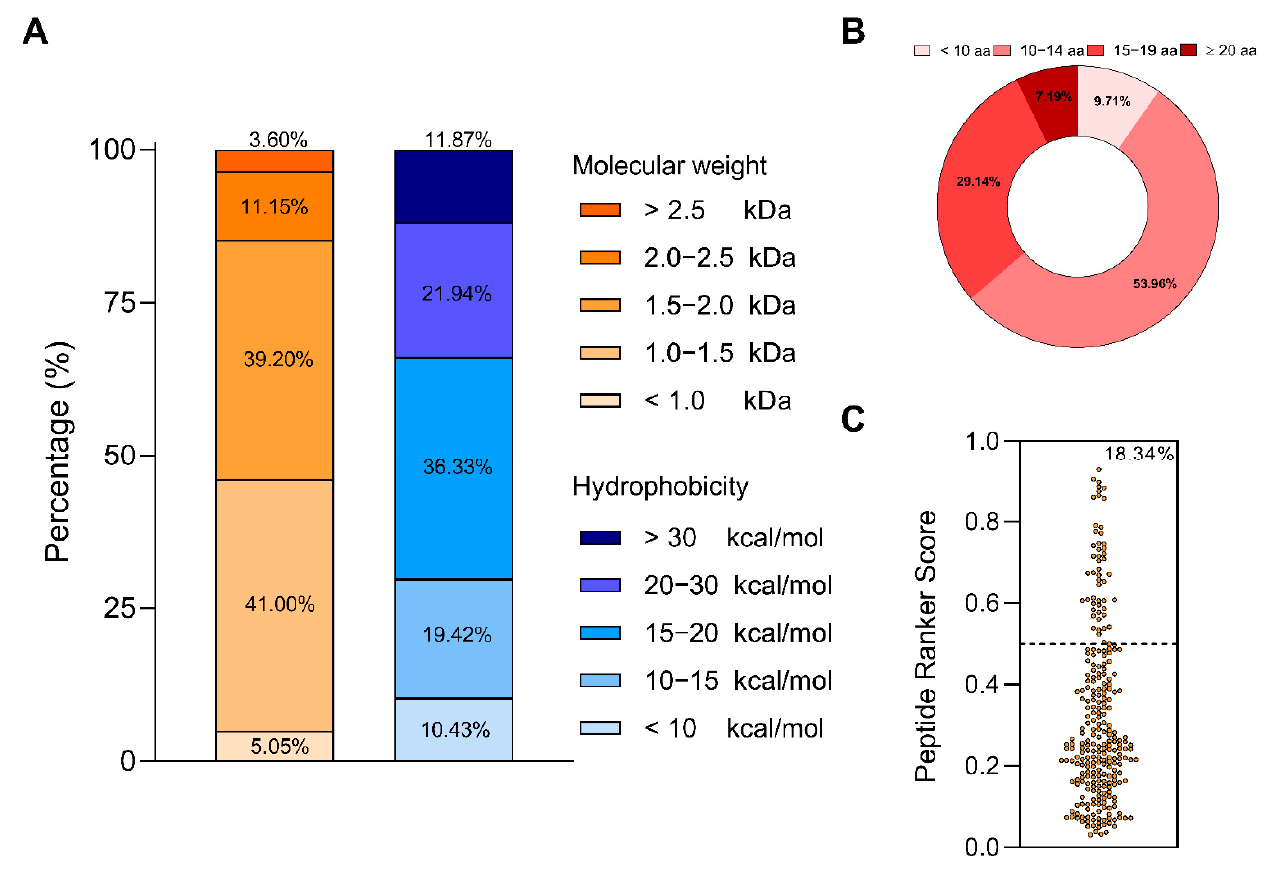
Figure 1. Percentage of molecular weight and hydrophobicity ( A ), length distribution ( B ), and predicted potential bioactivity ( C ) of the LPH peptides.